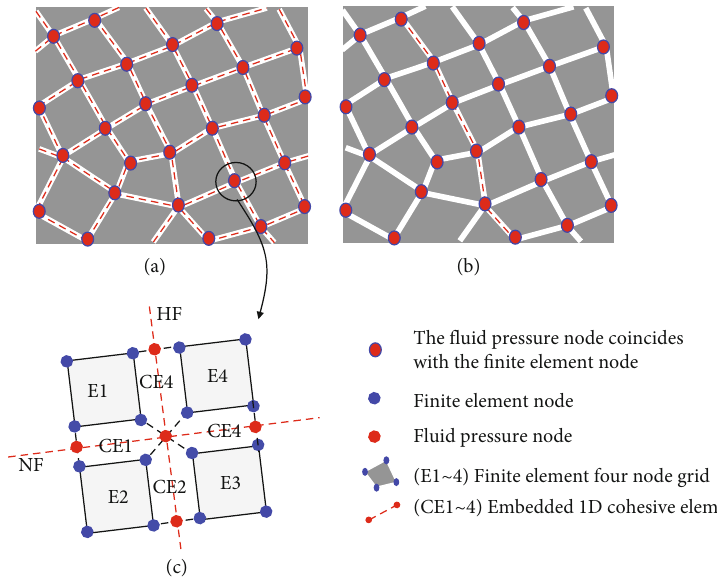
Figure 4: Global embedded cohesive zone model.